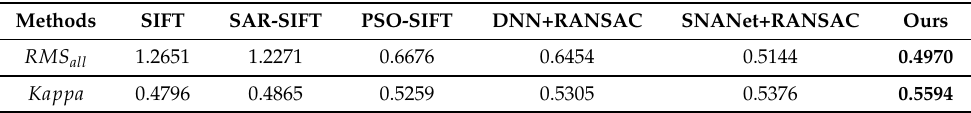
Table 7. Results of Change detection based on six registration methods for Bern Flood Data, where RMS all is the result of SAR image registration and Kappa is the result of SAR change